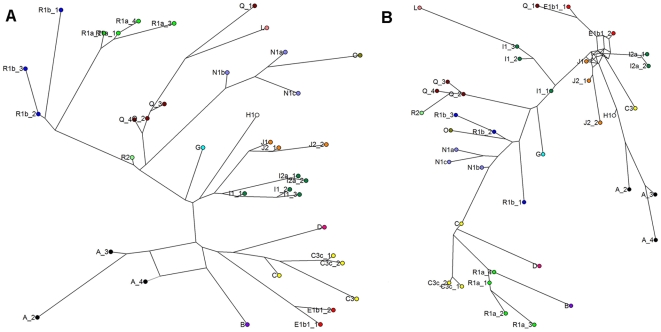
Networks of STR haplotypes based on tri- and tetranucleotide STRs, with and without SNPs.Median joining networks of Y chromosome STR haplotypes with balanced sample sizes from each haplogroup. A network based on 15 tri- and tetranucleotide STR markers and SNPs; B network based solely on the data of the 15 tri- and tetranucleotide STR markers used in this study. Nodes are named according to the haplogroups of the samples. STR markers employed in network construction: DYS19, DYS385a, DYS385b, DYS389I, DYS389II, DYS390, DYS391, DYS392, DYS393, DYS437, DYS439, DYS456, DYS458, DYS635, Y GATA H4.